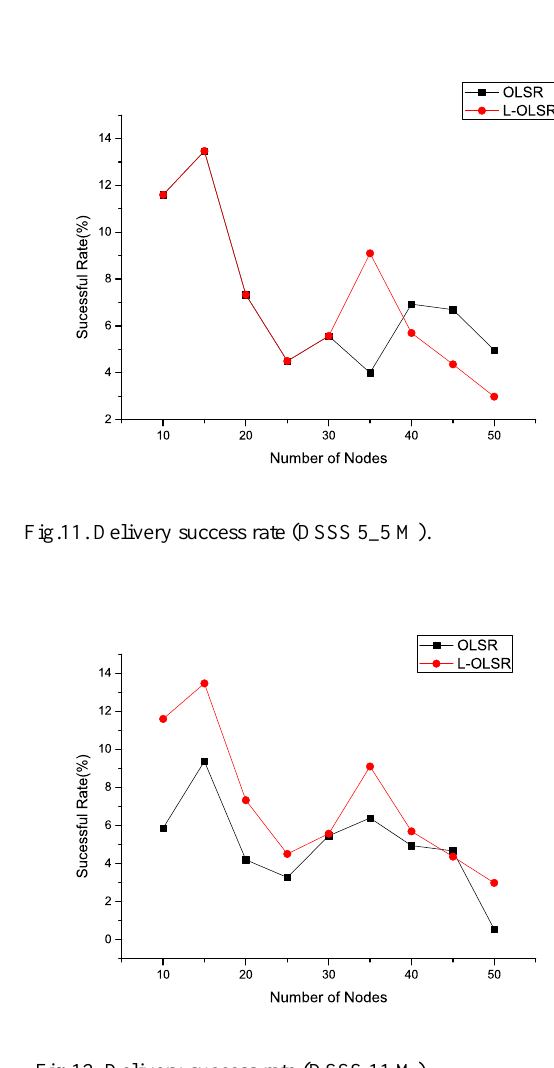
Fig.12. Delivery success rate (DSSS 11